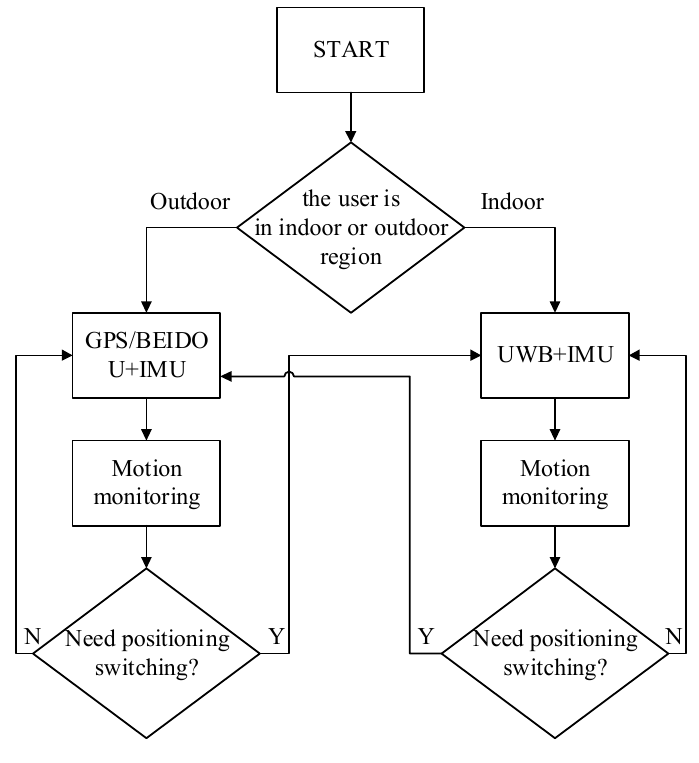
Figure 5. The architecture of the